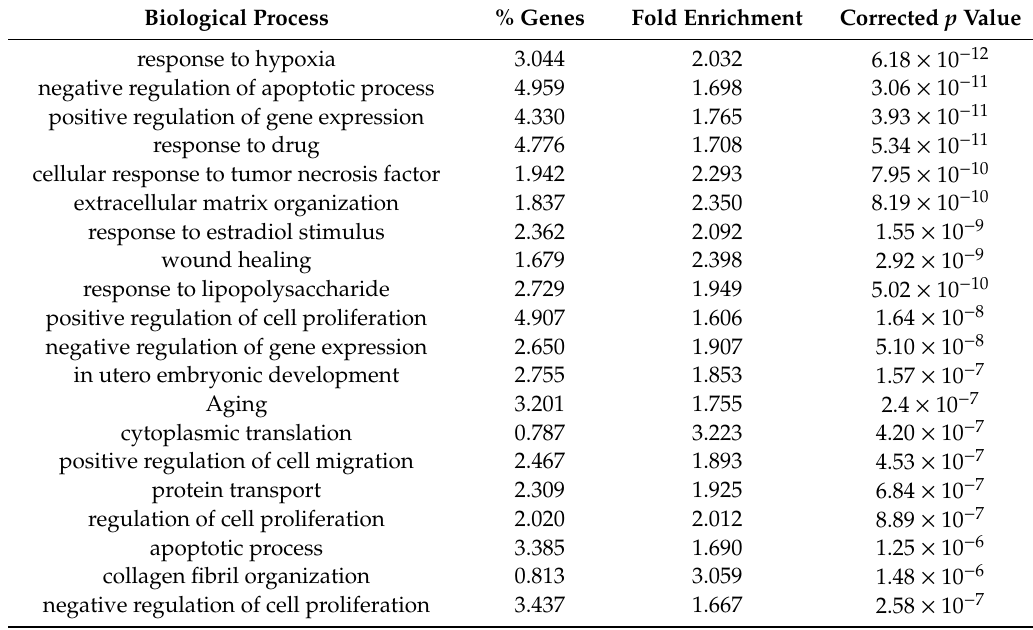
Table 1. Top 20 GO terms assigned to di ff erentially expressed genes in Il-1 β -stimulated tendon constructs after PEMF exposure.